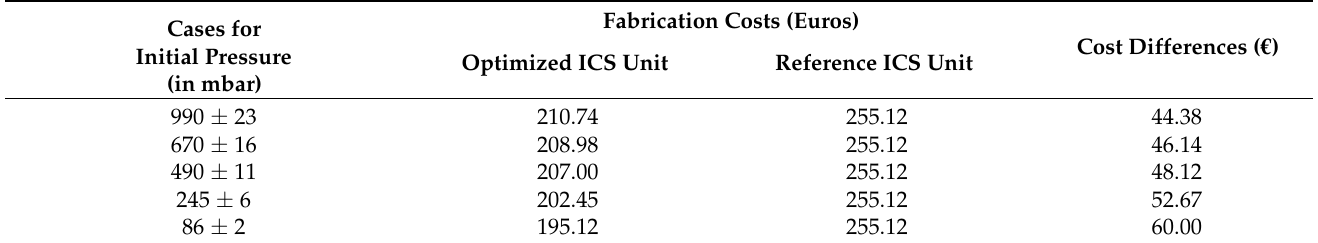
Table 2. Fabrication costs derived by the GUI environment and cost of the reference